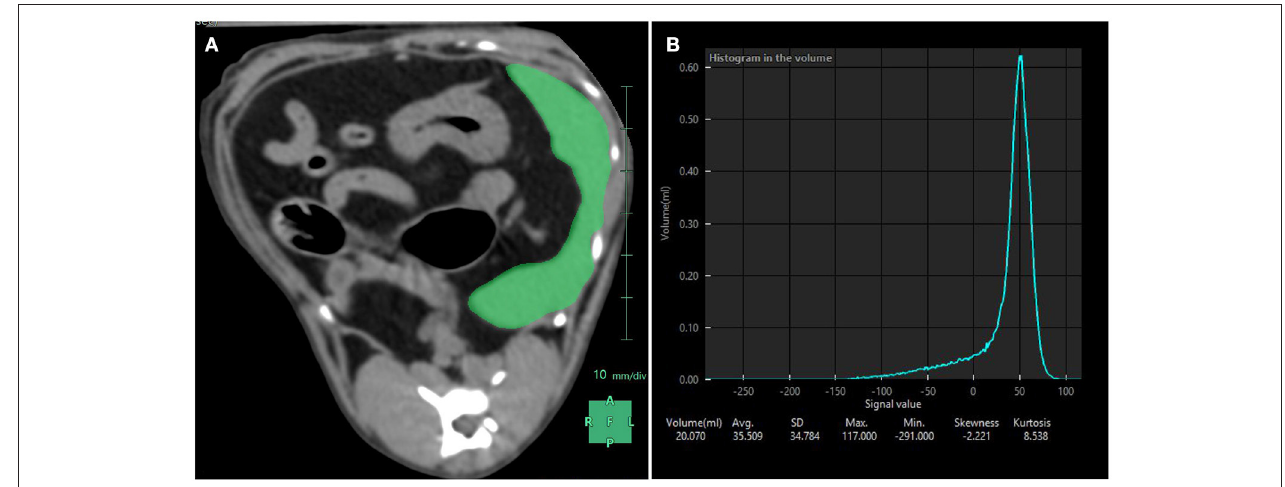
FIGURE 4 | Splenic volume measurements performed with CT. (A) Using a dedicated software, the spleen was manually contoured and subsequent region of interests averaged to compute a mask (in green) over the entire splenic volume. (B) Resulting splenic attenuation data are depicted as a histogram. At the bottom of the histogram are the splenic volume in mL, the average attenuation in Hounsfield Units (here 35.509 HU) and the corresponding standard deviation, maximum and minimum attenuation values included in the mask, skewness and kurtosis.